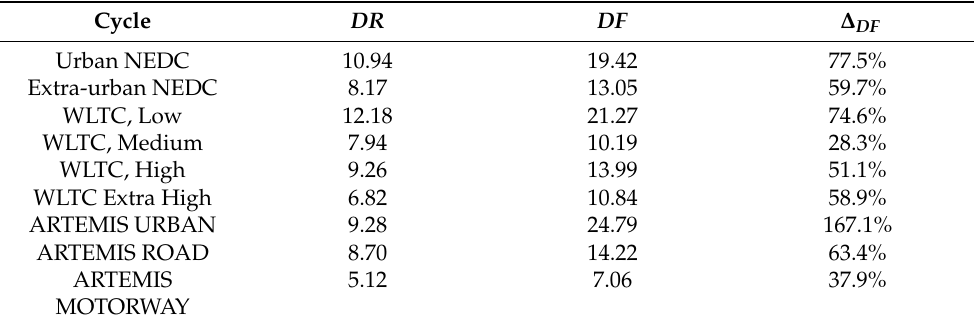
Table 6. Dilution ratio ( DR ) and dilution factor ( DF ) in each phase of NEDC, WLTC and ARTEMIS driving cycles for vehicle with CI engine, Euro